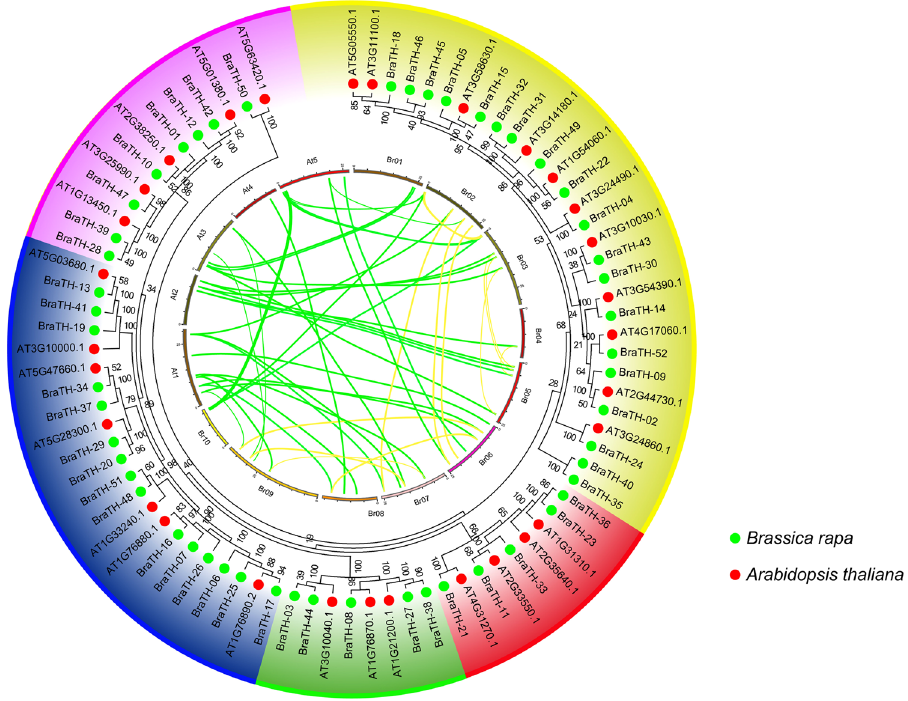
Figure 2. The syntenic trihelix genes between Brassica rapa and Arabidopsis thaliana . The ten Chinese cabbage chromosomes (Br01-Br10) and the five A. Thaliana chromosomes (At1-At5) are shown in different random colors. The green lines represent the syntenic genes pairs between Chinese cabbage and Arabidopsis , the yellow lines represent the syntenic genes in Chinese cabbage.